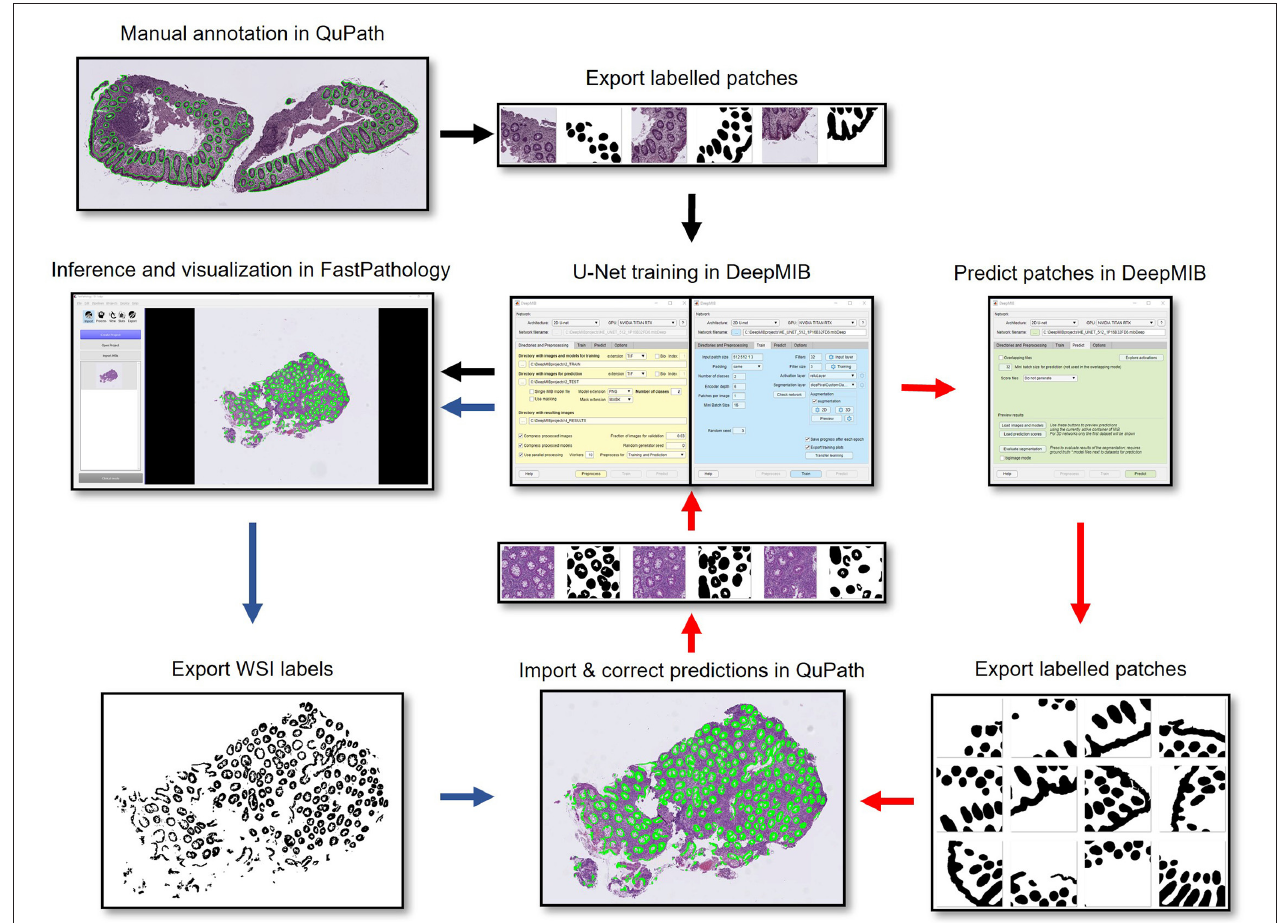
FIGURE 1 | Flowchart showing the pipeline from manual annotation in QuPath, export of labeled patches from QuPath (black arrows), CNN training in DeepMIB, expansion of the dataset by predicting unseen WSIs in DeepMIB and importing and correcting predictions in QuPath (red arrows), and final export of trained networks as ONNX-files and rapid prediction directly on WSIs in FastPathology (blue